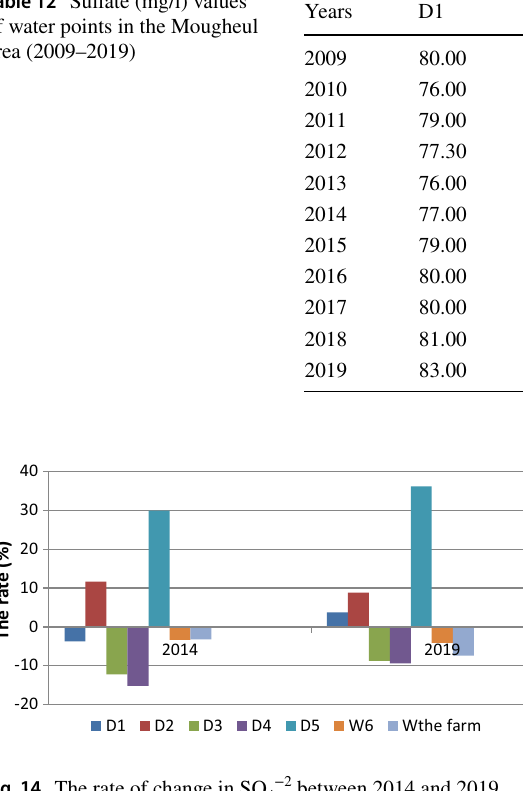
Fig. 14 The rate of change in SO 4−2 between 2014 and 2019 Table 13 Nitrate (mg/l) values of water points in the Mougheul area